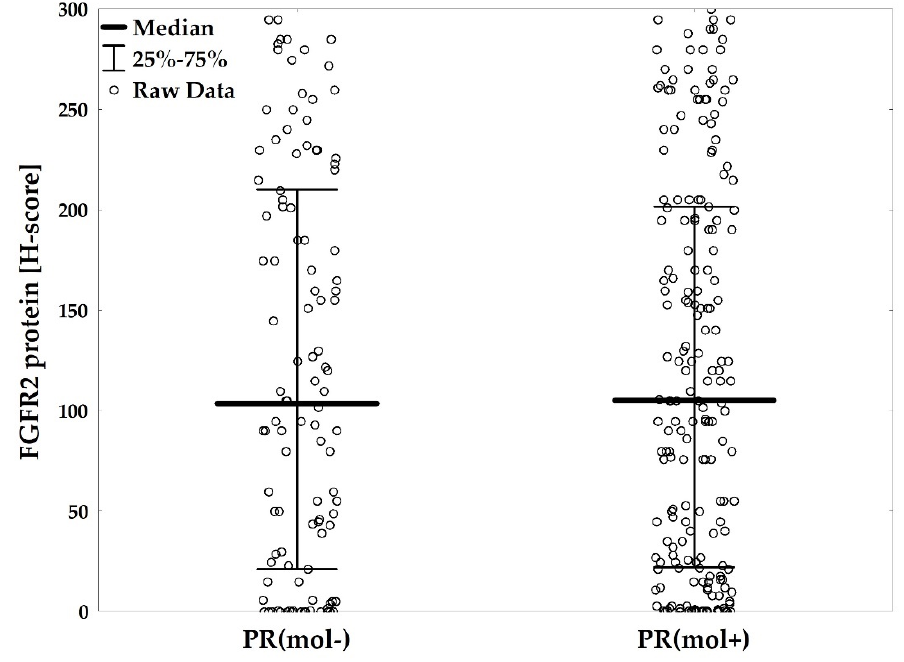
Figure 5. FGFR2 protein levels (H-score) compared regarding progesterone receptor molecular activity status (PR(mol − ) vs. PR(mol + )), p < 0.001. p -values from Kruskal–Wallis ANOVA test .